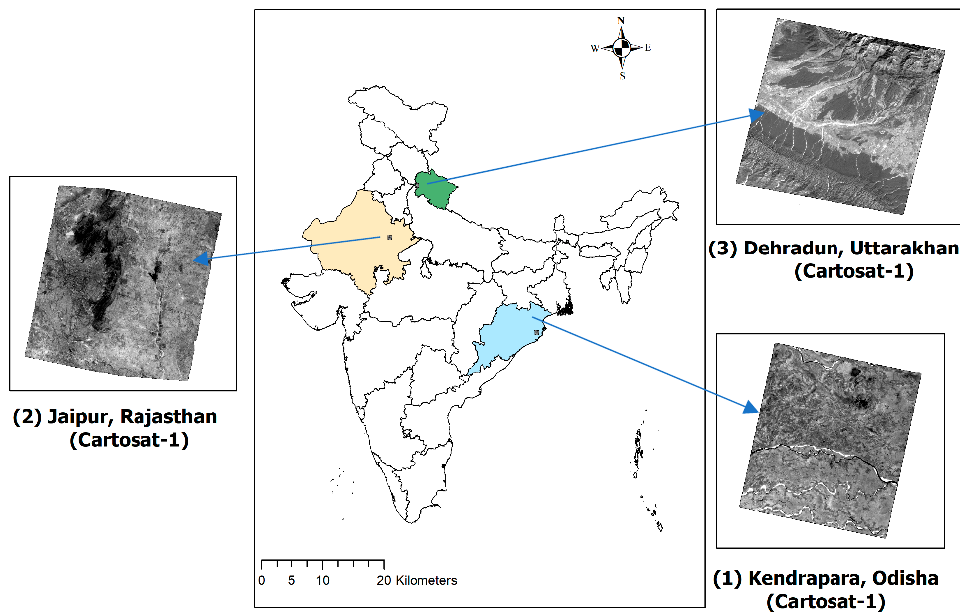
Figure 1. Depicts the locations and Cartosat-1 orthoimages for the three experimental sites namely, ( 1 ) Dehradun Site, Uttarakhand; ( 2 ) Jaipur Site, Rajasthan; and ( 3 ) Kendrapara Site, Odisha.